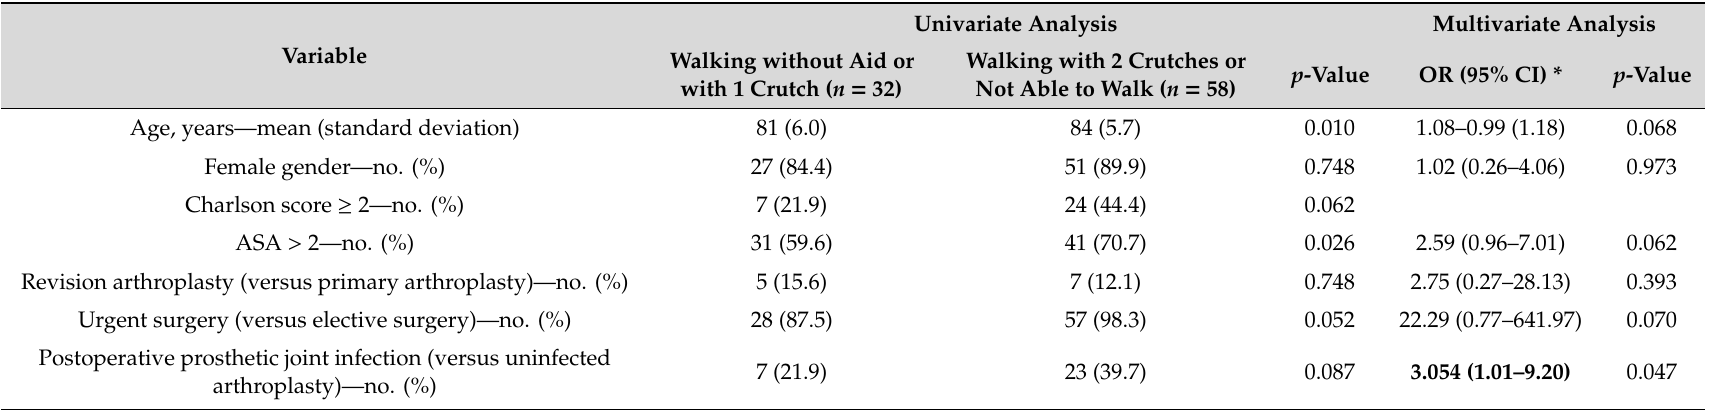
Table 5. Factors associated with requiring two crutches to walk or not being able to walk versus walking without assistance or with one crutch in patients undergoing partial hip joint replacements one year after the last surgical